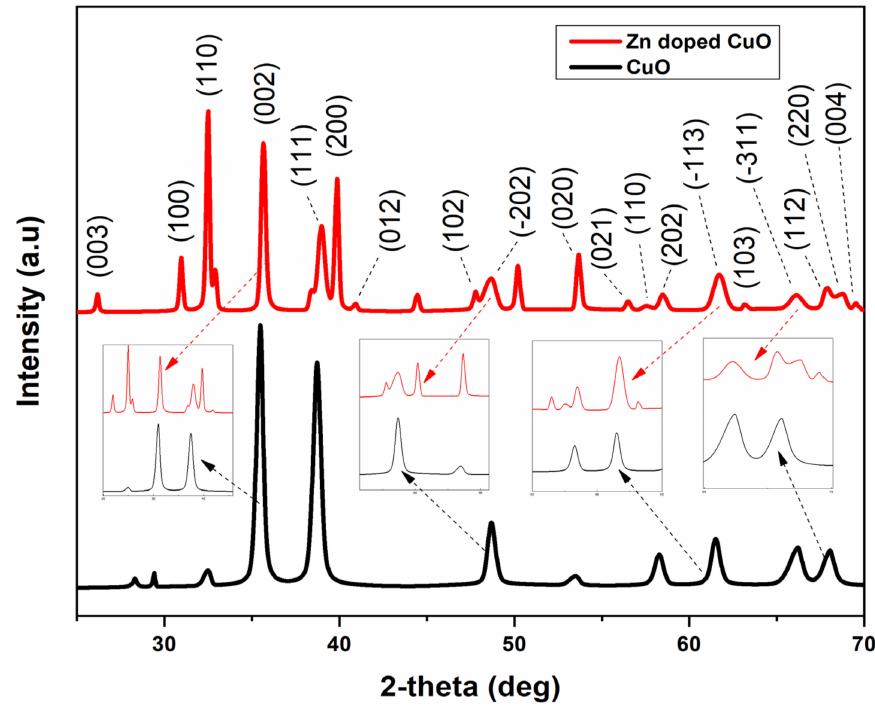
Figure 2. XRD pattern of Zn-doped CuO nanoparticles showing peaks for different content in the